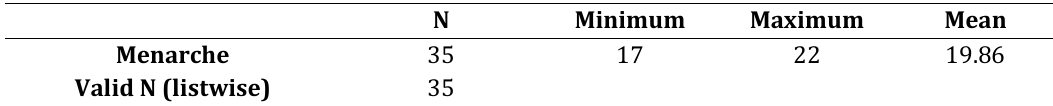
Characteristics of Research Respondents based on Respondent Age